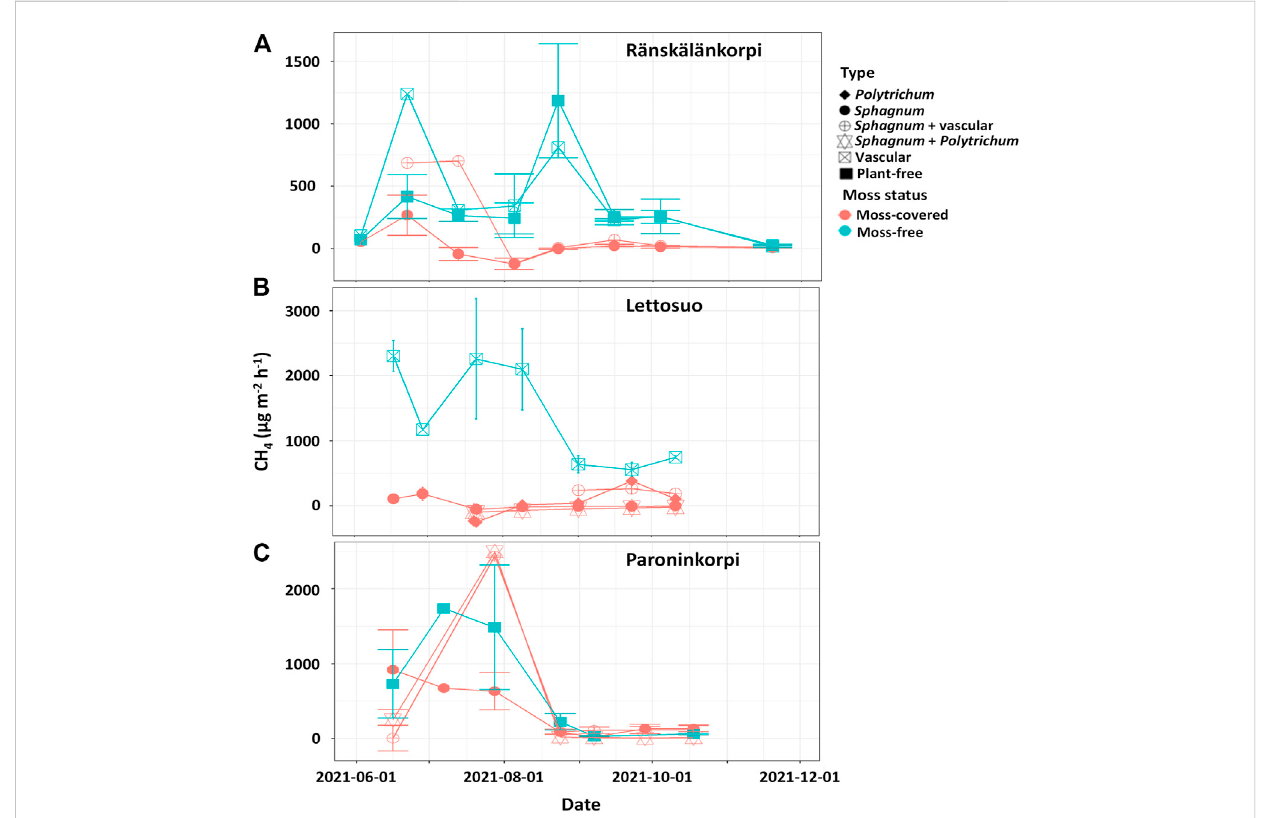
FIGURE 1 Temporal variation of measured CH 4 fl ux in different types of measurement points of ditches (average +/- SE) at (A) Ränskälänkorpi, (B) Lettosuo, and (C) Paroninkorpi forestry-drained peatland area in